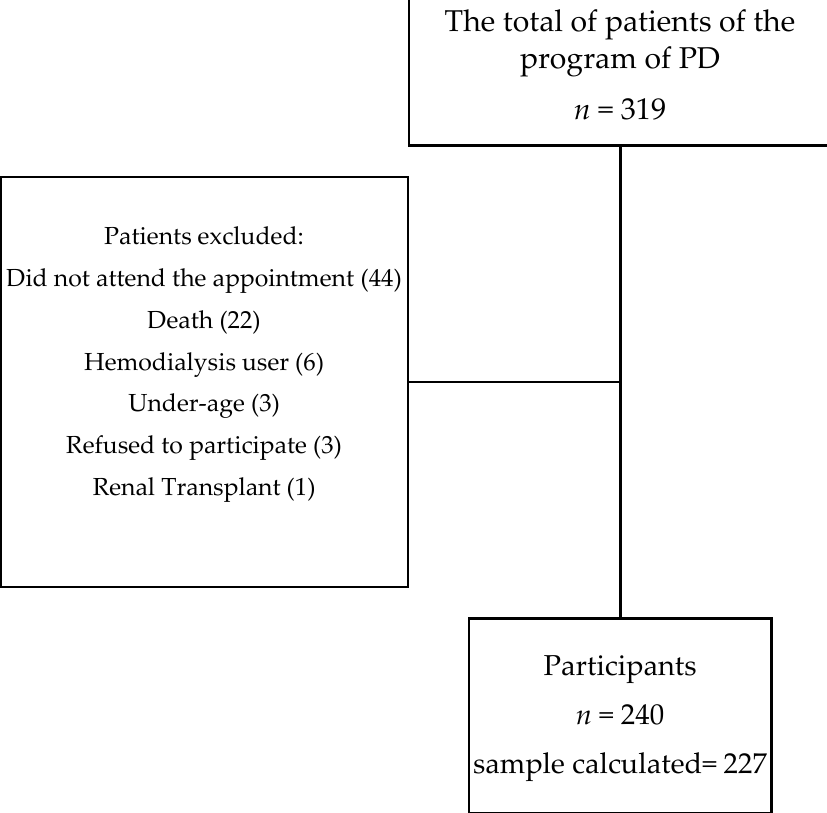
Figure 1. The study population selection. PD, peritoneal dialysis.